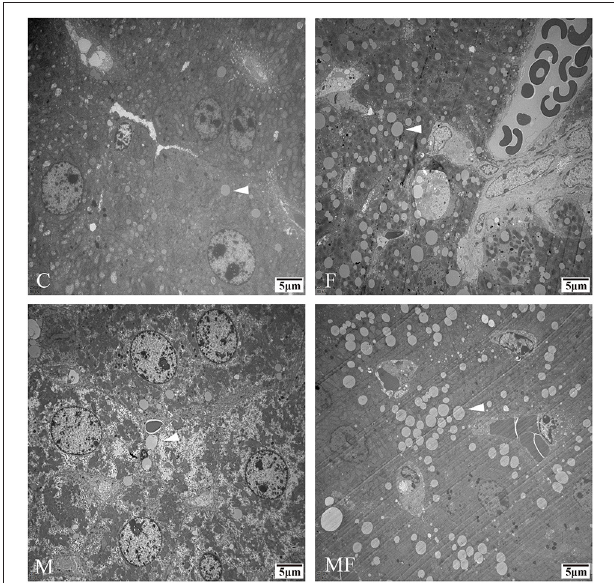
FIGURE 5 | Representative TEM images depicting the number of lipid droplets in the livers of control mice vs. those with intermittent fasting and/or melatonin treatment. Scale bar: 5 µ m. Images of the fasting groups (F and MF) revealed a great number of lipid droplets (white arrows). C, control; F, intermittent fasting; M, melatonin; MF, intermittent fasting plus melatonin. TEM, Transmission electron